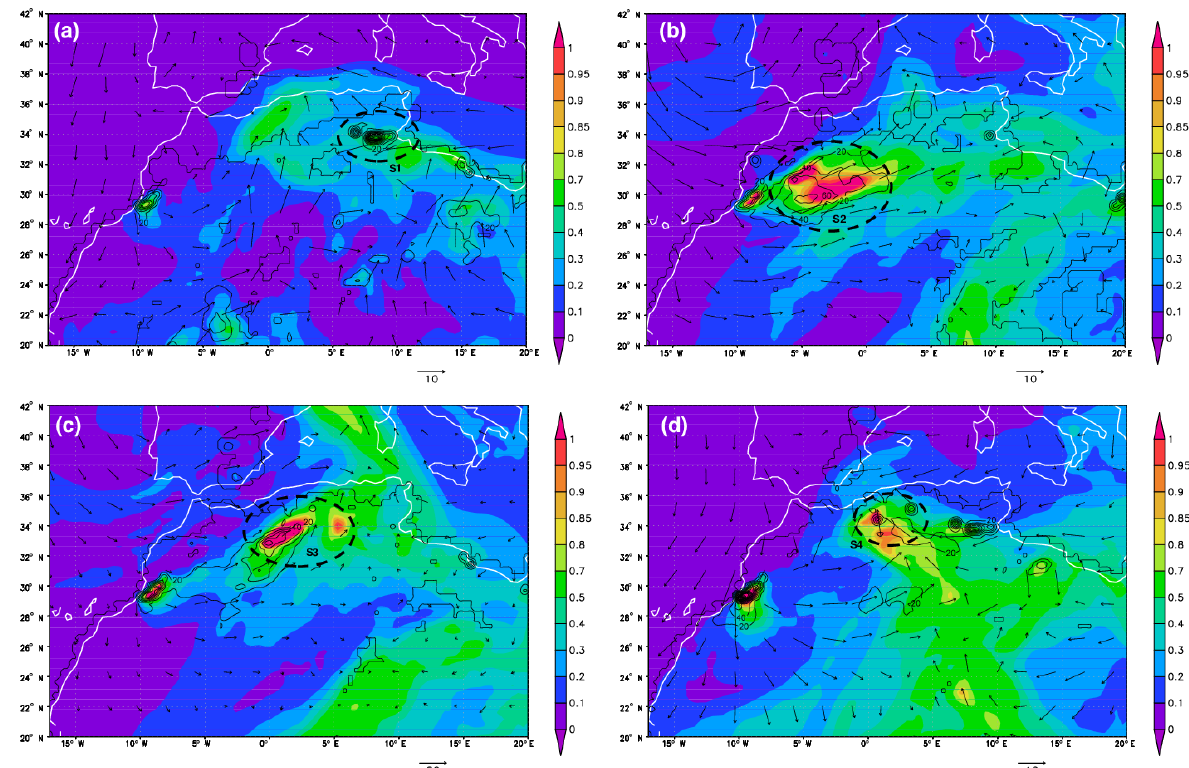
Figure 4. Model (S01) AOD at 550nm (shaded contour), dust source strength (black contour) and black arrows ( u,v ) at 1000hPa. The dashed ovals (S1, S2, S3, S4) denote the locations of the desert regions identified as responsible for the northward dust intrusion of 18 May (a) , 20 May (b) , 21 May (c) and 24 May (d)